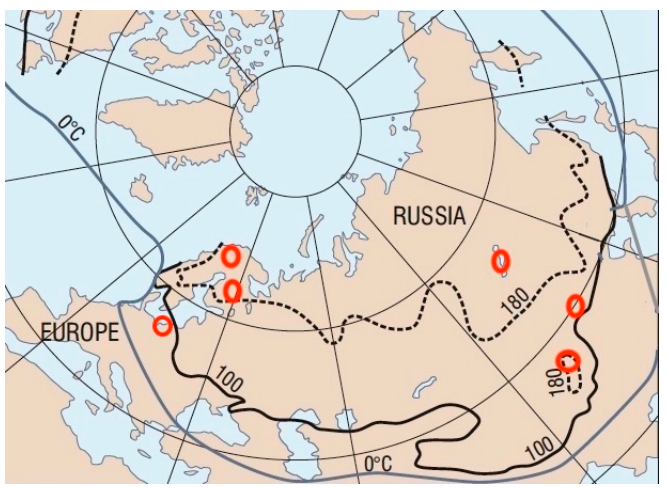
Figure 1. The Eurasian continent with contours for lake ice season of 100 and 180 days [6], together with the mean January 0 °C contour of air temperature. The study sites are marked by red circles.